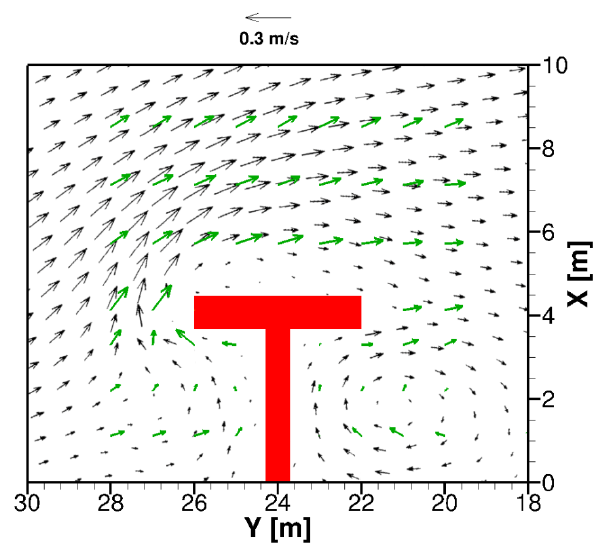
Figure 5. Time-averaged and depth-averaged velocity field. Calculated by the proposed model (black vectors) and measured by [33] (green vectors).